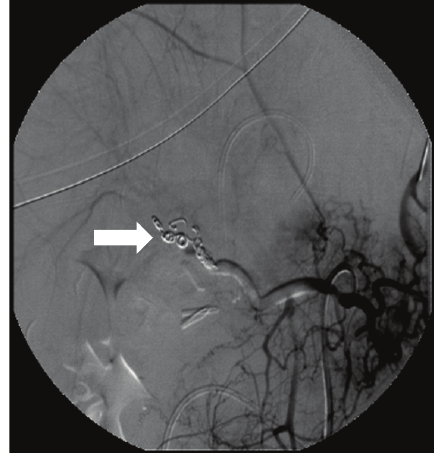
Figure 2: After embolization, the arteriogram shows 3-4mm coils obstructing the replaced right hepatic artery with complete disap- pearance of the